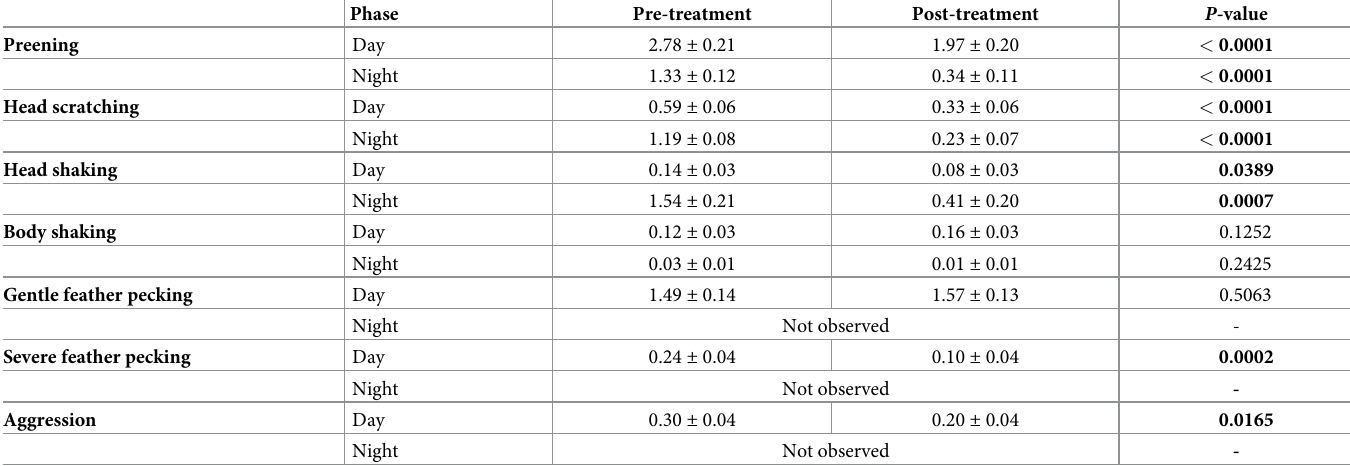
Table 3. Behavioural variables (least square means ± standard deviations); bouts per bird during 15 minutes observation pre- (Weeks -6 to -1) and post-treatment (Weeks 0 to +6).